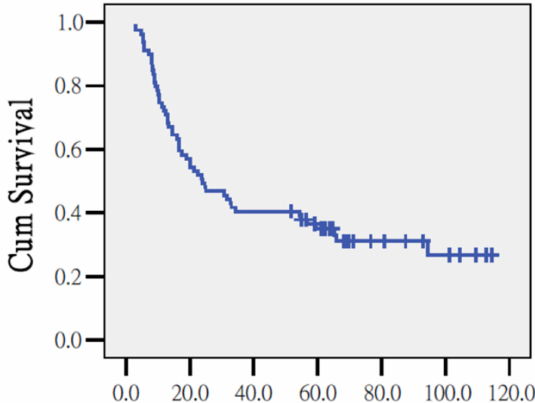
Figure A3. Overall survival for whole population. Months after